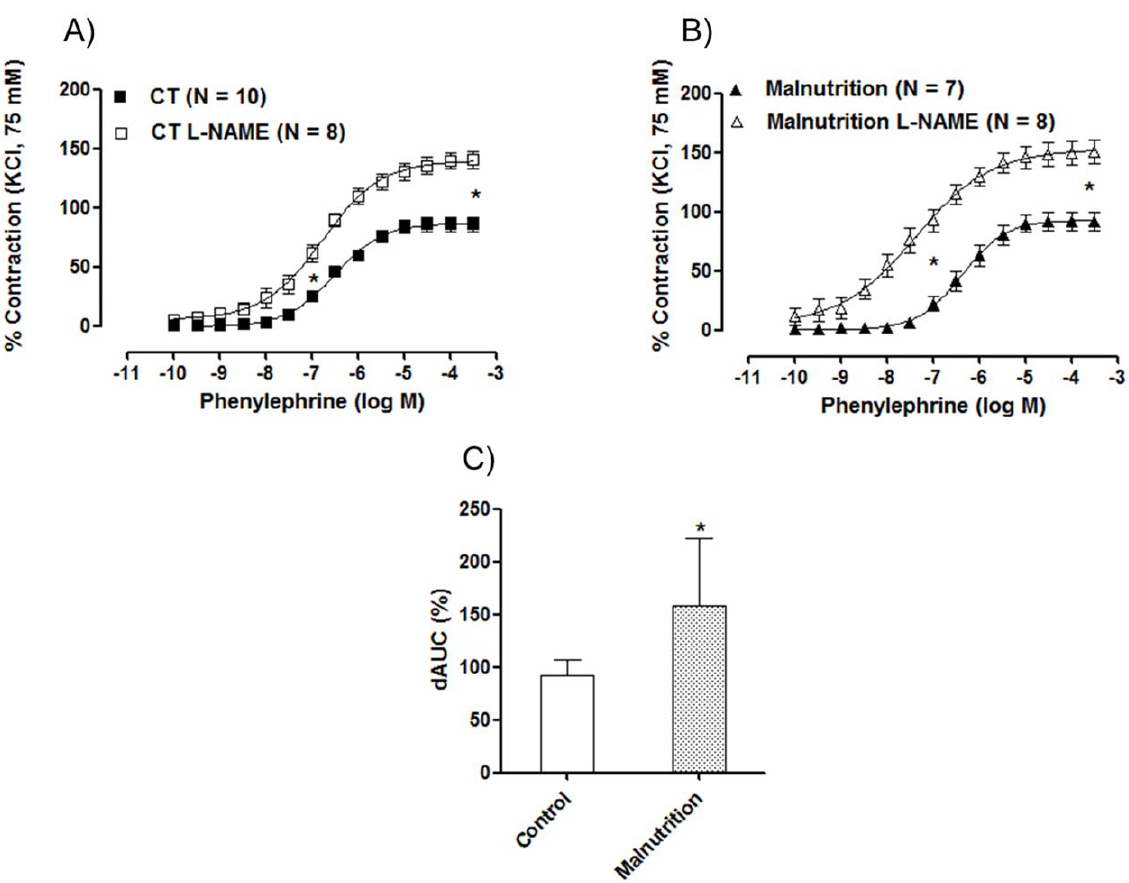
Figure 2. The effects of N G -nitro-L-arginine methyl ester (L-NAME, 100 m M) (A, B) on the concentration-response curve to phenylephrine in isolated aortic rings from control (CT) and post-weaning protein malnutrition (Malnutrition). (C) Comparison of the percent difference of the area under the curve (% dAUC) in vessels in presence or absence of L-NAME from control (CT) and post-weaning protein malnutrition (Malnutrition) groups. The number of preparations is indicated in parenthesis. The results are expressed as the means 6 SEM. * P , 0.05 for pD2 and R max : CT E + vs. CT L-NAME; pD2 and R max : Malnutrition E + vs. Malnutrition L-NAME and dAUC% CT vs. Malnutrition by Student’s t -test.